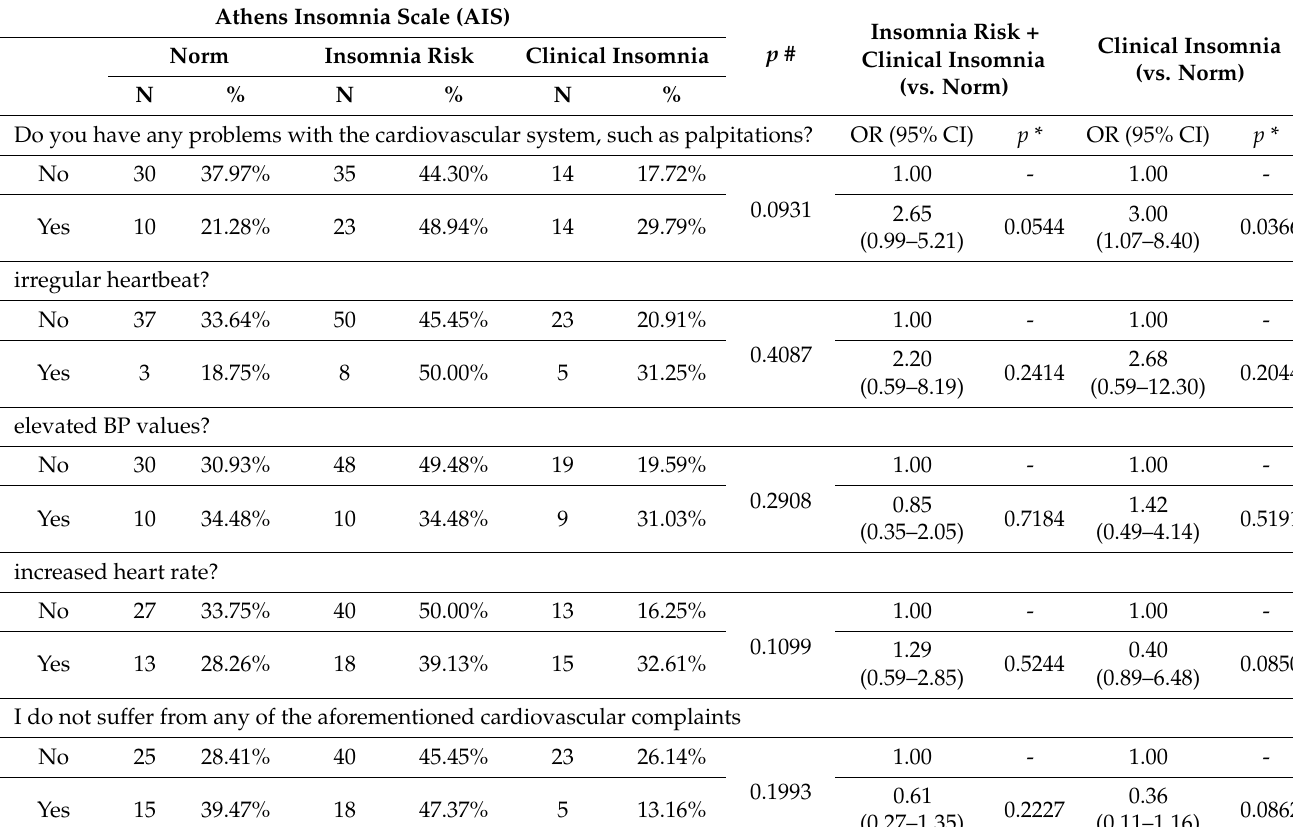
Table 6. Disorders of the cardiovascular system and the risk of sleep